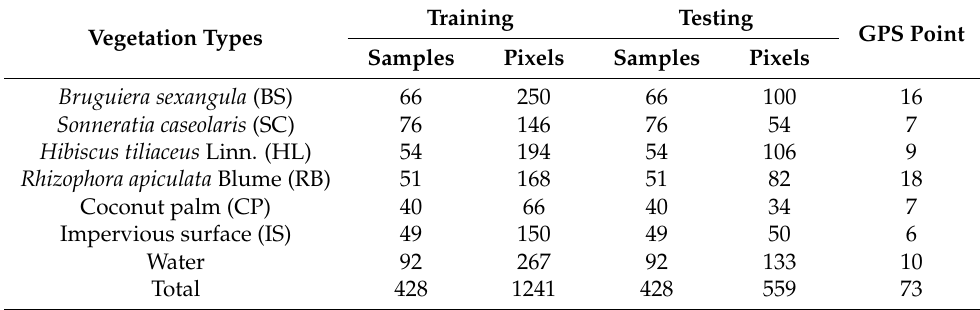
Table 1. Vegetation types and their samples for image classification.